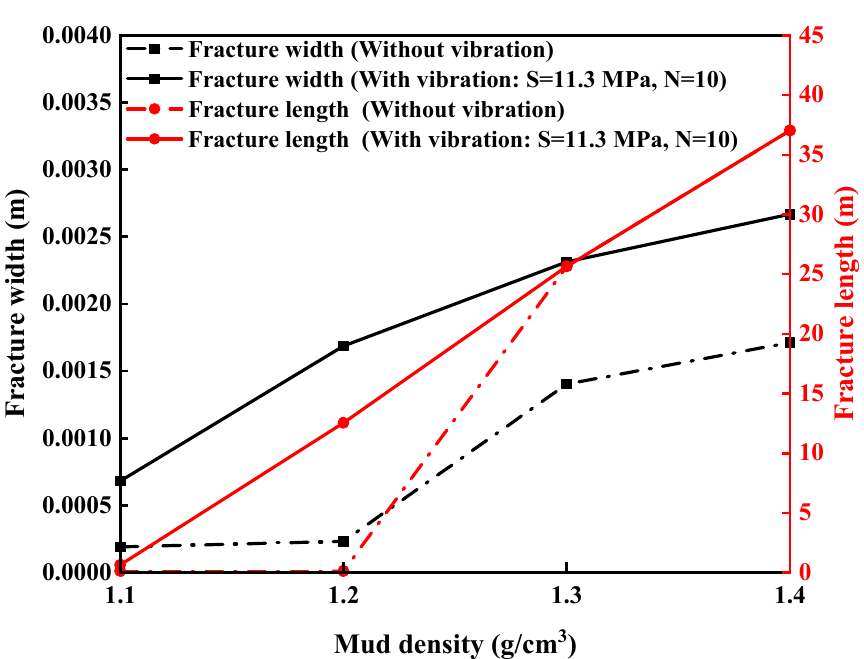
Figure 12. Effect of mud density on fracture length and fracture width with and without vibration cyclic loads.